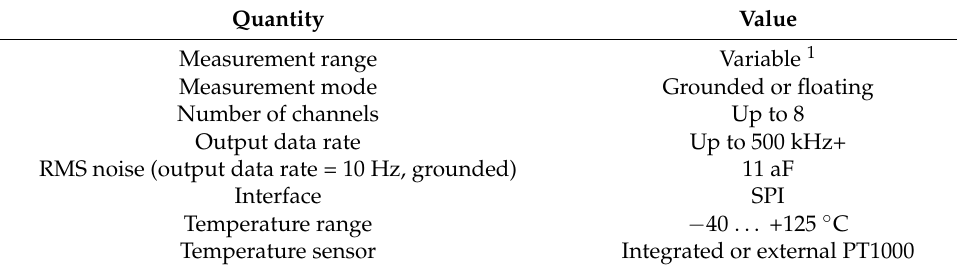
Table 1. PCap01 specifications; Data extracted from